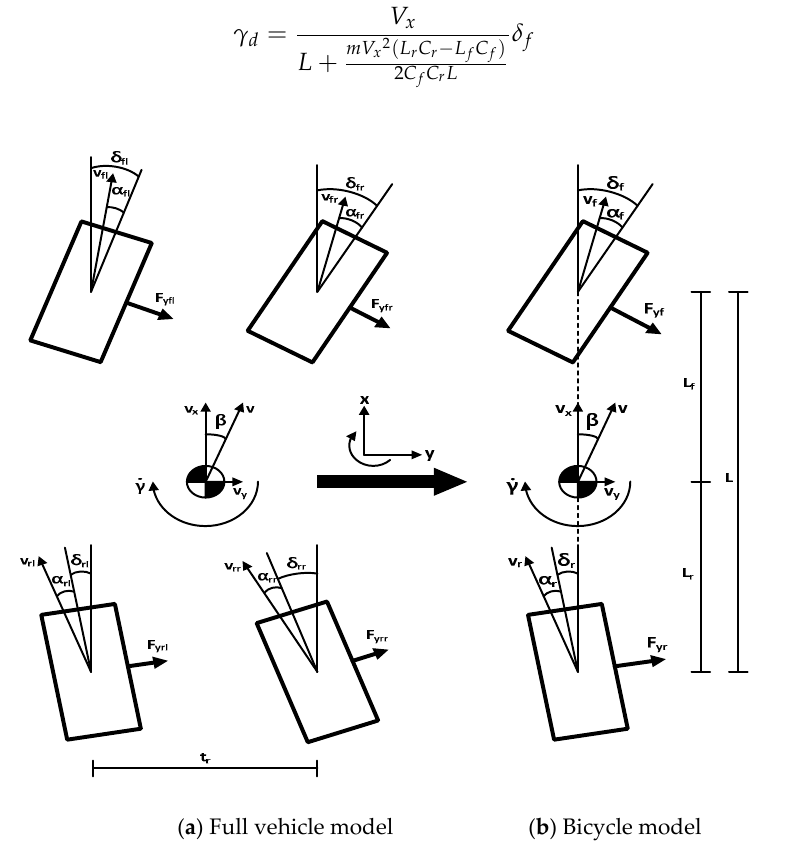
Figure 3. Schematic diagram of full vehicle and bicycle lateral dynamics model.